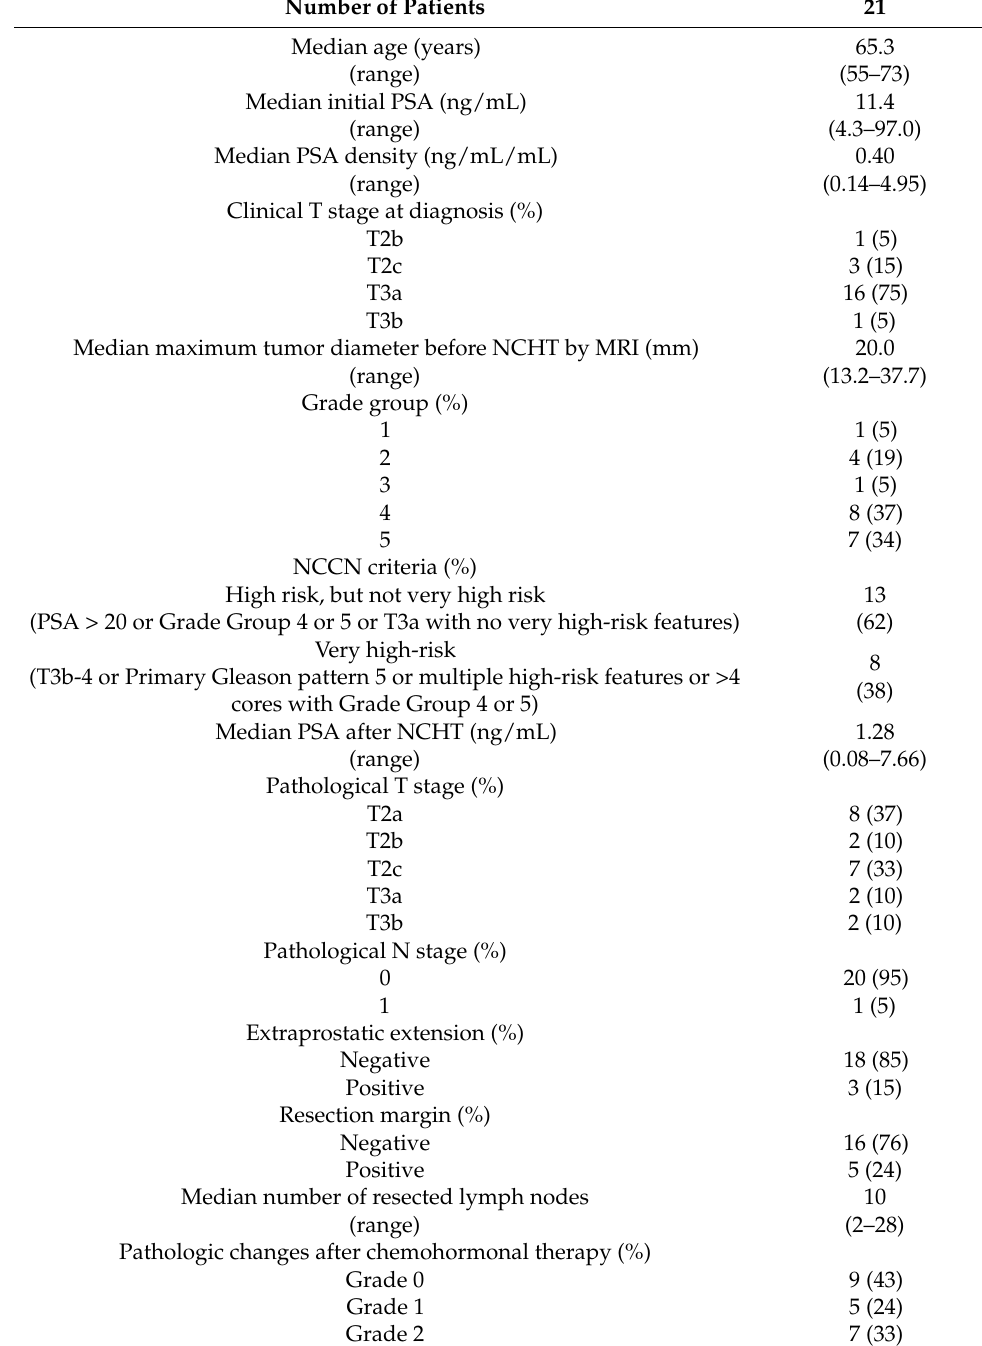
Table 1. Patients and pathologic characteristics at